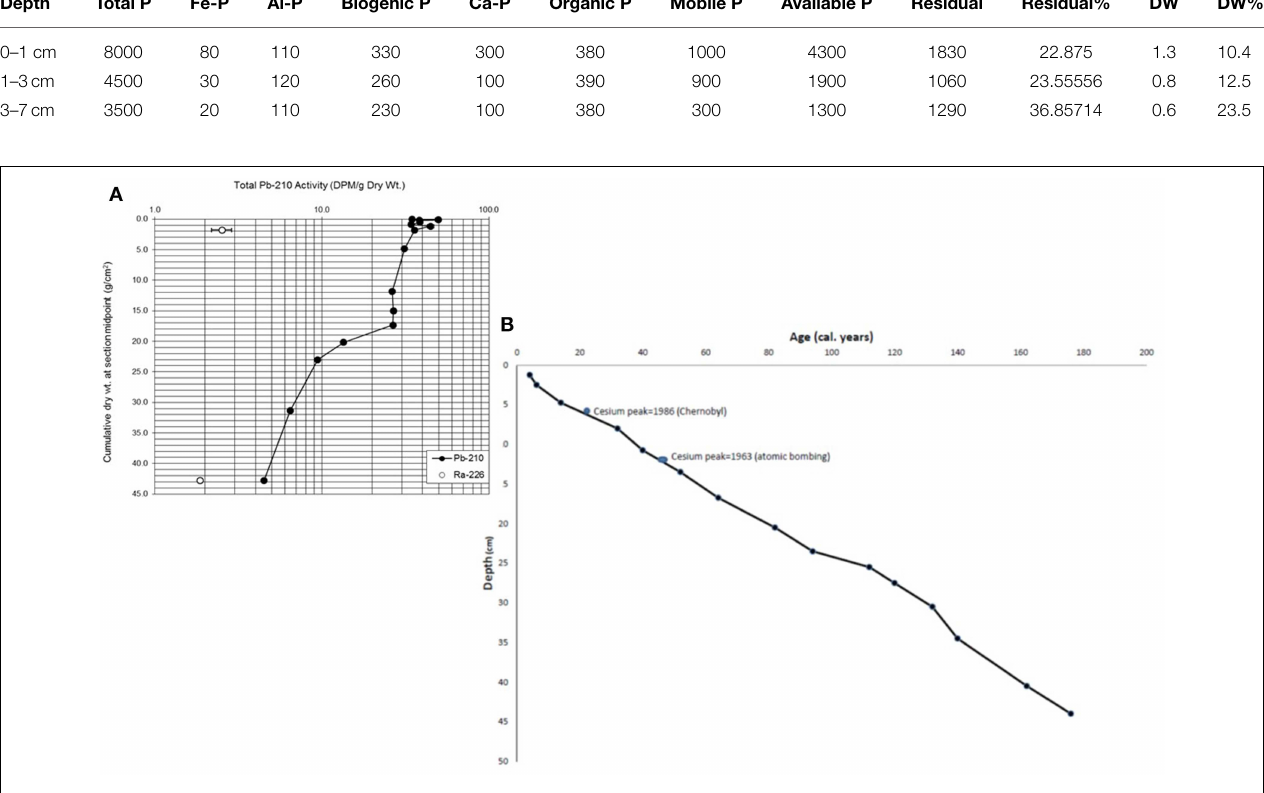
FIGURE 3 | (A) Lead concentration. Graph provided by Flett Research. (B) Age-depth model developed using the Bayesian calibration program OxCal 4.2 (Bronk Ramsey, 2013 ) and constrained to the know peaks of 137 Cesium in 1986 (Chernobyl) and 1963 (Von Gunten et al.,